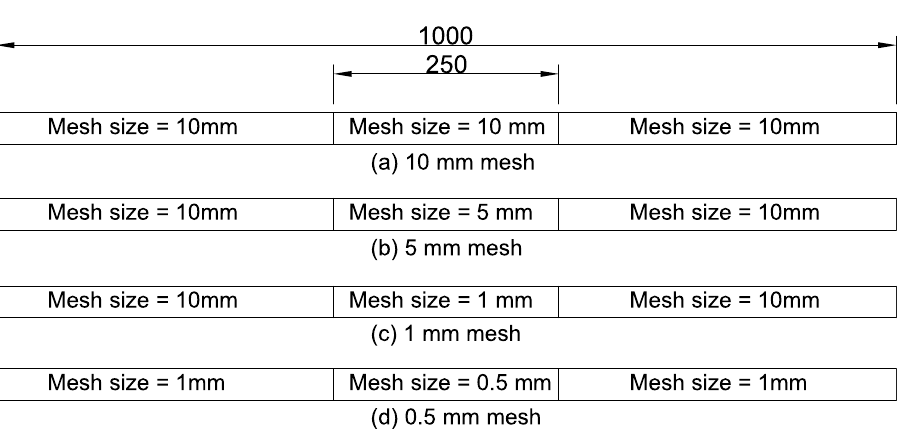
Figure 10. Four different mesh size strategies for the FEA model of the beam. ( a ) 10 mm mesh, ( b ) 5 mm mesh, ( c ) 1 mm mesh, ( d ) 0.5 mm